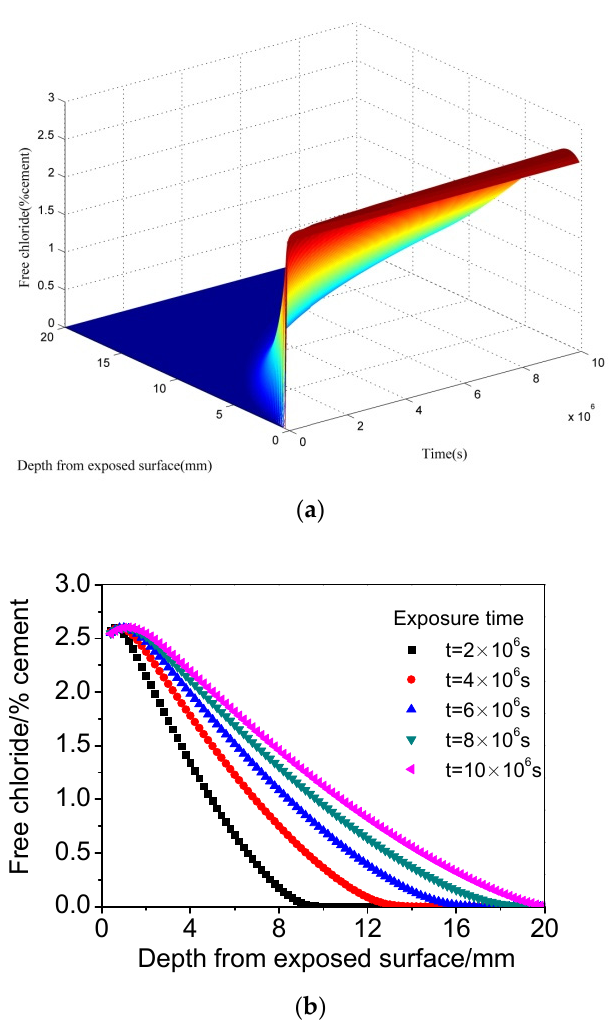
Figure 2. The calculated chloride distribution of concrete subjected to cyclic wetting–drying condi- tions when the CO 2 concentration is zero. ( a ) Three dimensions. ( b ) Two dimensions.